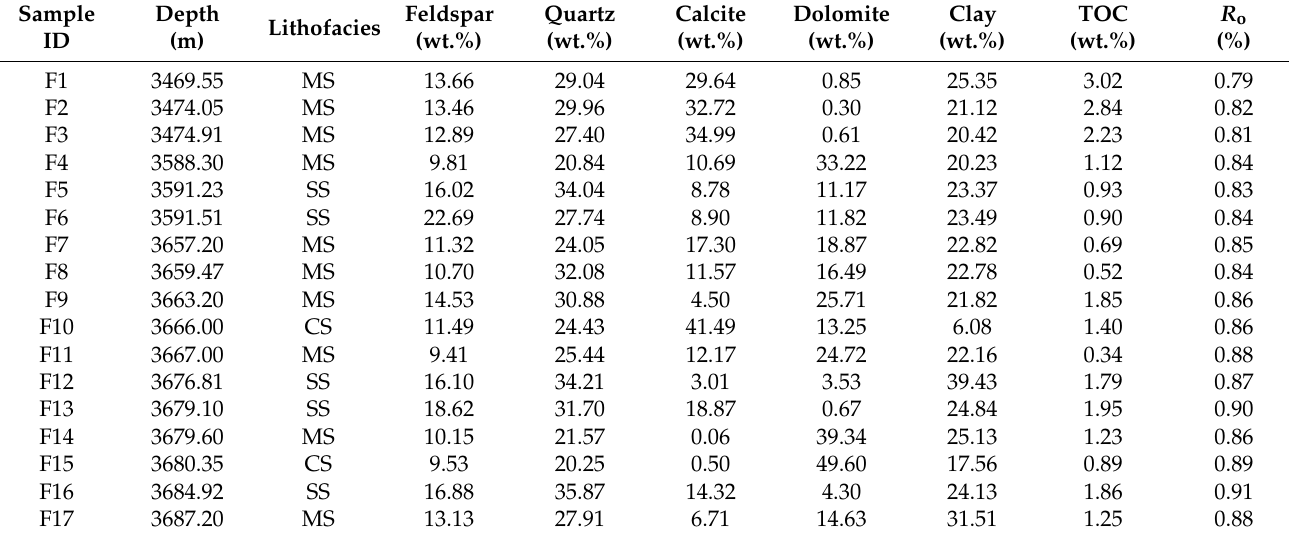
Table 1. TOC contents and mineral compositions of all